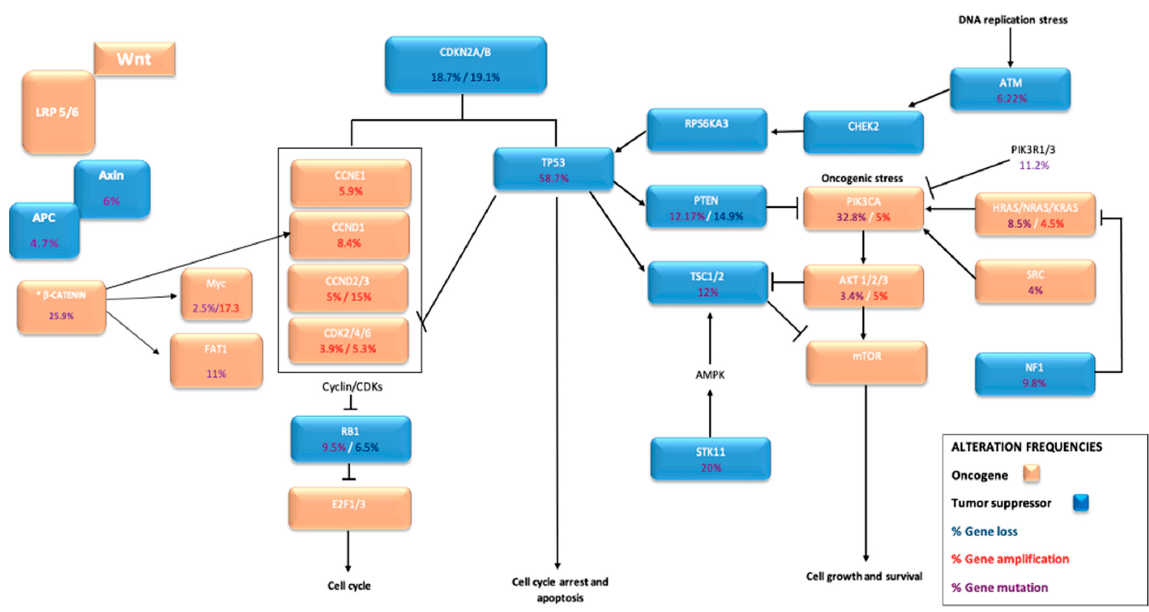
Figure 3. The most frequently altered genes in metaplastic breast cancer. * Mutation frequency reported by Hayes et al. [42] and not found by other authors. These data have been obtained from the review of the reference [11].